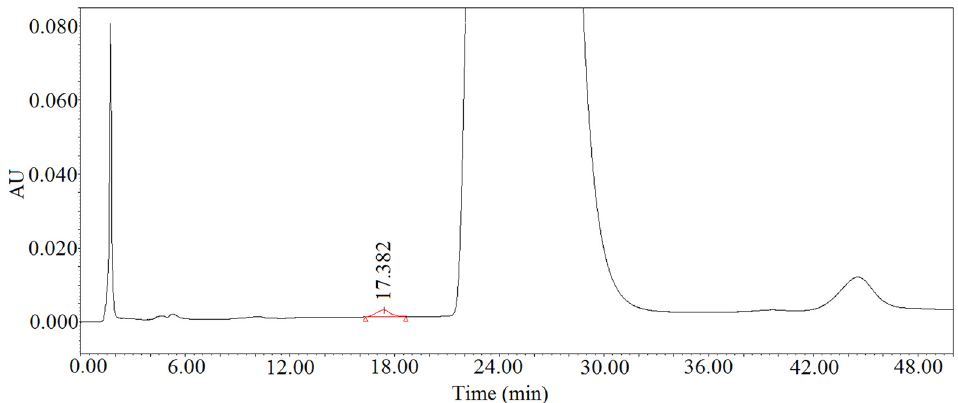
Figure 3: High - performance liquid chromatogram for the representative samples of prepreg.